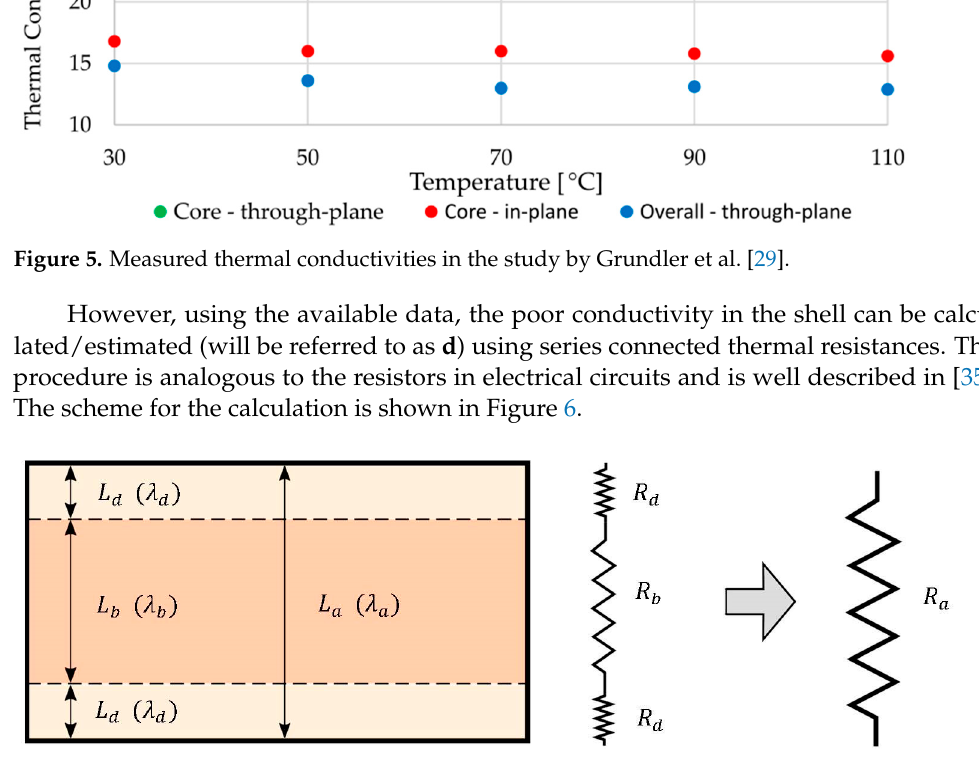
Figure 6. Calculation scheme for estimating the poor thermal conductivity in the shell.